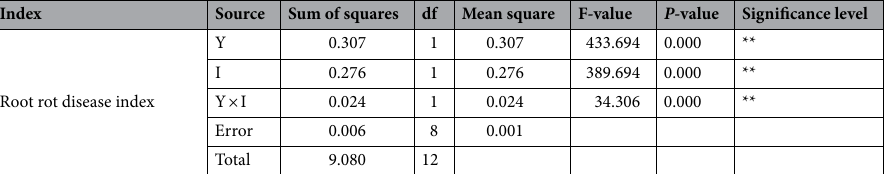
Table 3. Variance analysis of the factorial design of soybean growth/yield and disease index of soybean root rot. Y represents continuous cropping regimes. I represents inoculated with R. intraradices . *Factors are significant at P < 0.05 level. **Factors are significant at P < 0.01 level.